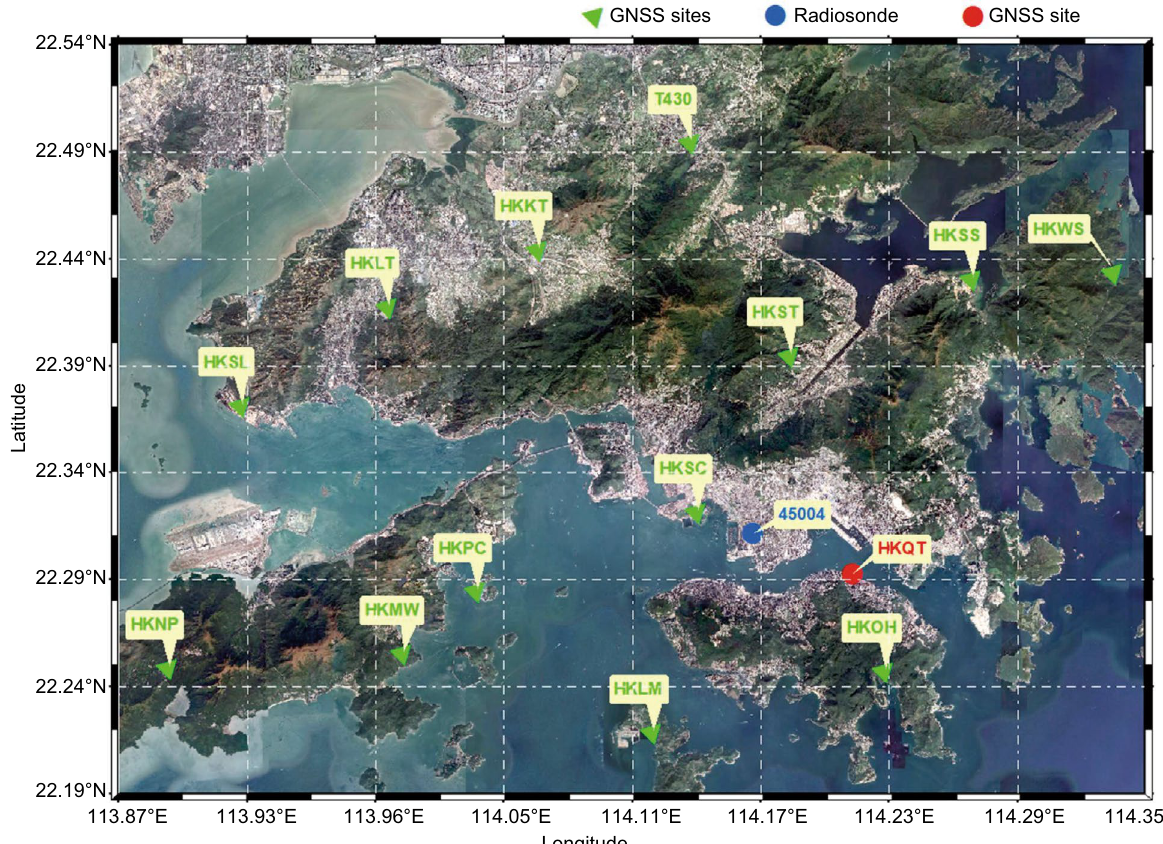
Fig. 1 Distribution of GNSS and radiosonde sites and the horizontal structure of the